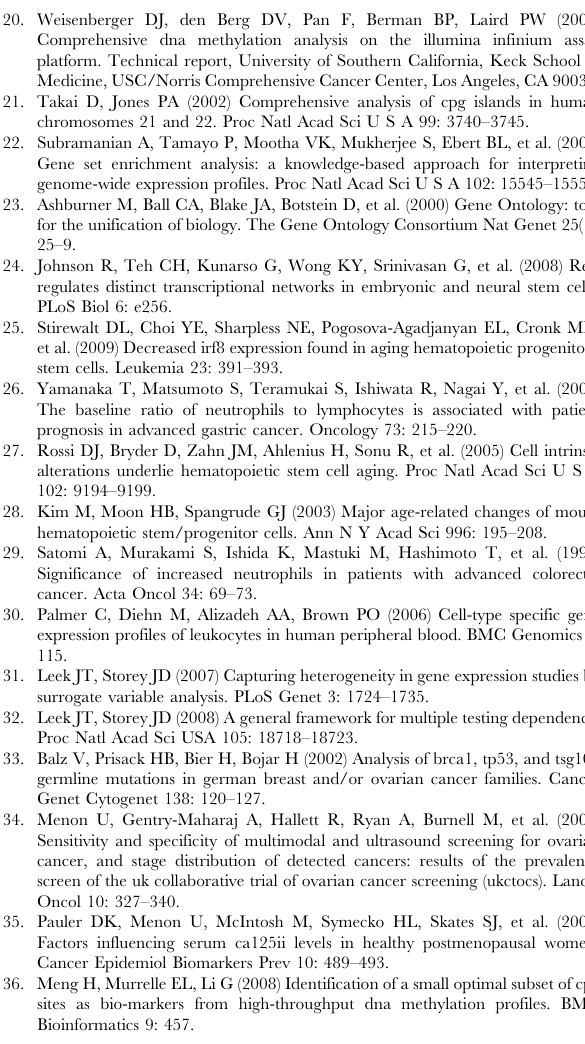
Table S3 Summary of Gene Set Enrichment Analysis results on CpGs in blood undergoing significant hyper- and hypomethylation with age and with presence of ovarian cancer.